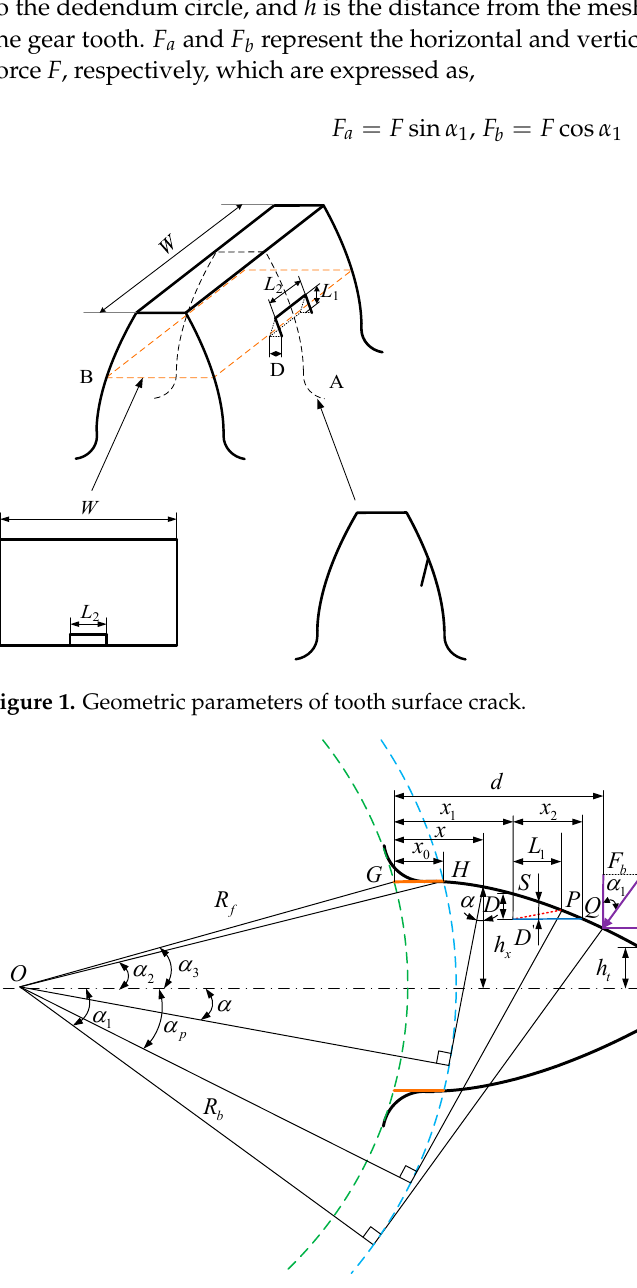
Figure 2. The cantilever beam model of gear with tooth surface crack fault.